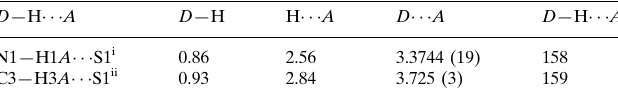
Hydrogen-bond geometry (A˚ , (cid:1)